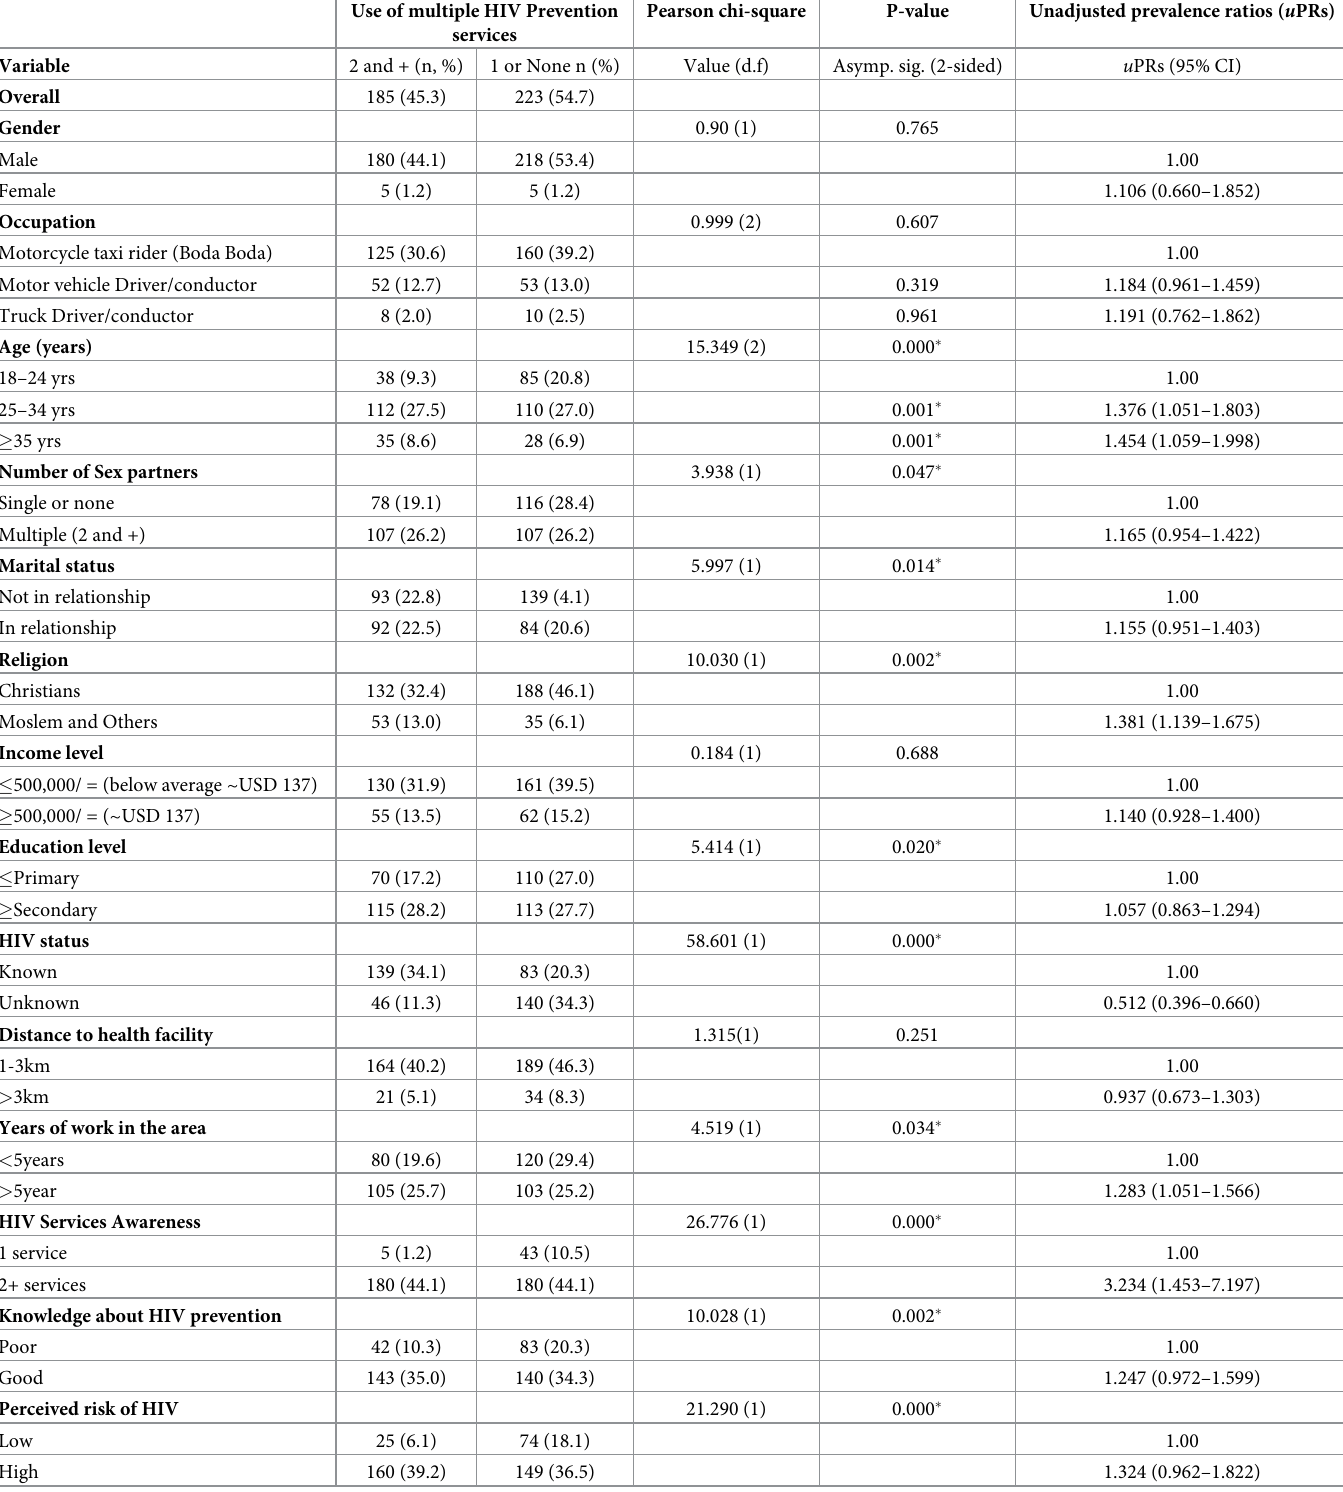
Table 4. Factors associated with the use of multiple HIV prevention